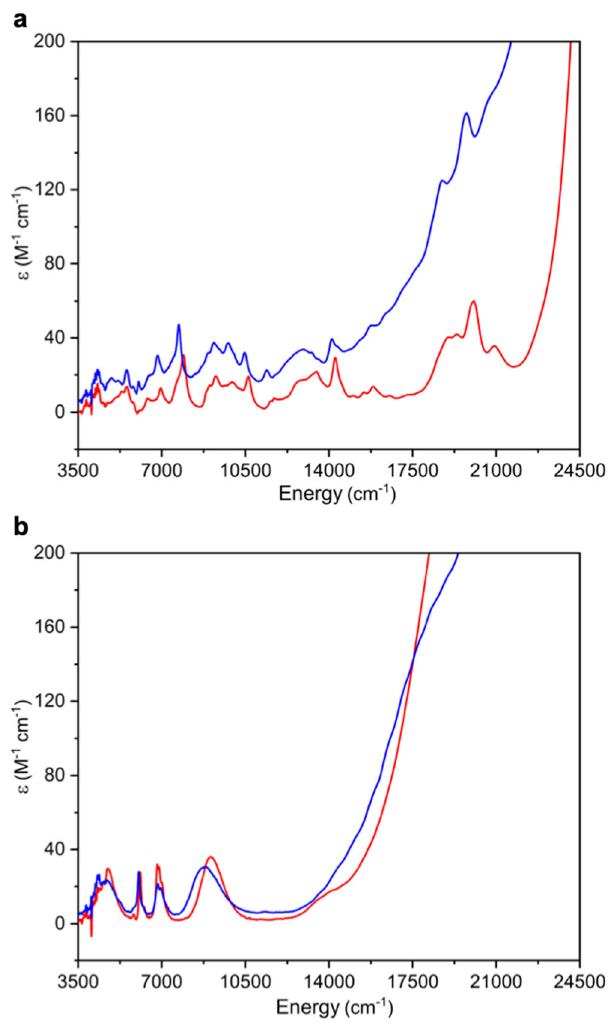
Fig. 4 Variable-temperature effective magnetic moment SQUID data for uranium(IV)-imido (3M) and uranium(V)-nitride (5M) complexes. a μ eff ( μ B ) vs T (K) data in a 0.5 T external fi eld for 3Li (black squares), 3Na (red circles), 3K (blue triangles), 3Rb (violet triangles), and 3Cs (green squares). b μ eff ( μ B ) vs T (K) data in a 0.5 T external fi eld for 5Li (black squares), 5Na (red circles), 5K (blue triangles), 5Rb (violet triangles), and 5Cs (green squares).